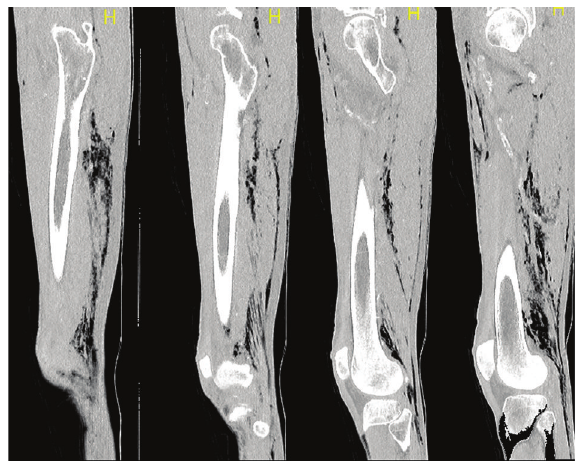
Figure 3: Sagittal sequence of the same CT scan.